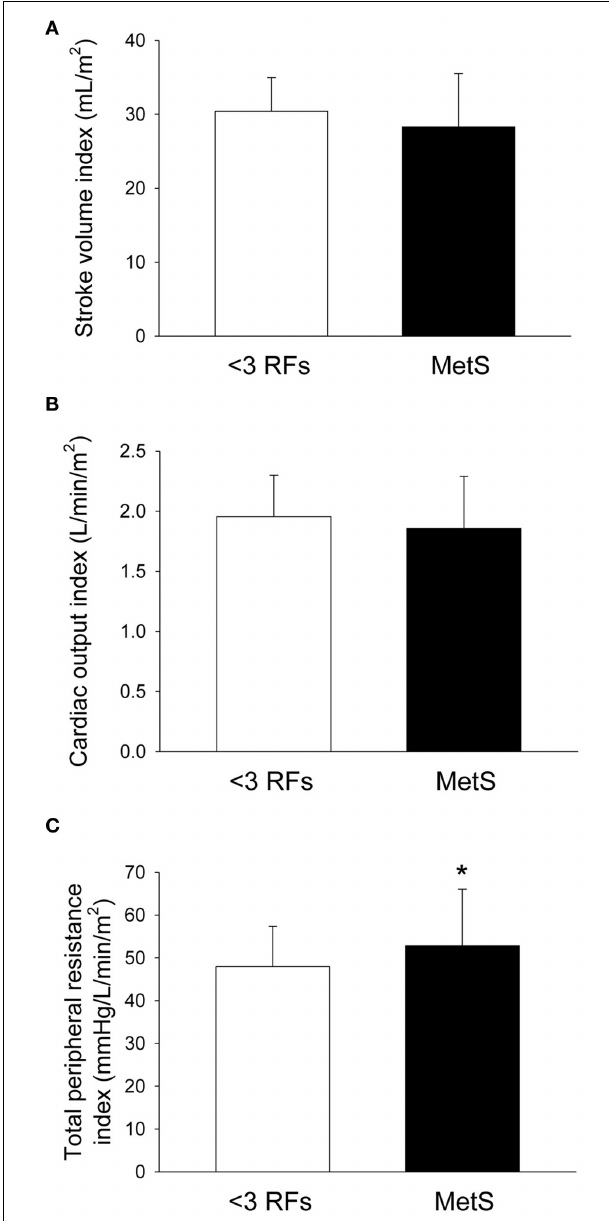
FIGURE 4 | Hemodynamics of individuals with metabolic syndrome (MetS). After adjustment for statin and anti-hypertensive medication use, compared with individuals with less than three risk factors for cardiovascular disease ( < 3 RFs) participants with MetS displayed (A) no difference in stroke volume index ( P = 0.19); (B) no difference in cardiac output index ( P = 0.34); and (C) higher total peripheral resistance index ( P = 0.04).There were no significant effects of anti-hypertension medication use or statin use for all variables.Values are mean ± SD. Corresponding SE values are (A) 0.9mL/m 2 ( < 3 RFs) and 1.1mL/m 2 (MetS); (B) 0.06L/min/m 2 ( < 3 RFs) and 0.07L/min/m 2 (MetS); (C)